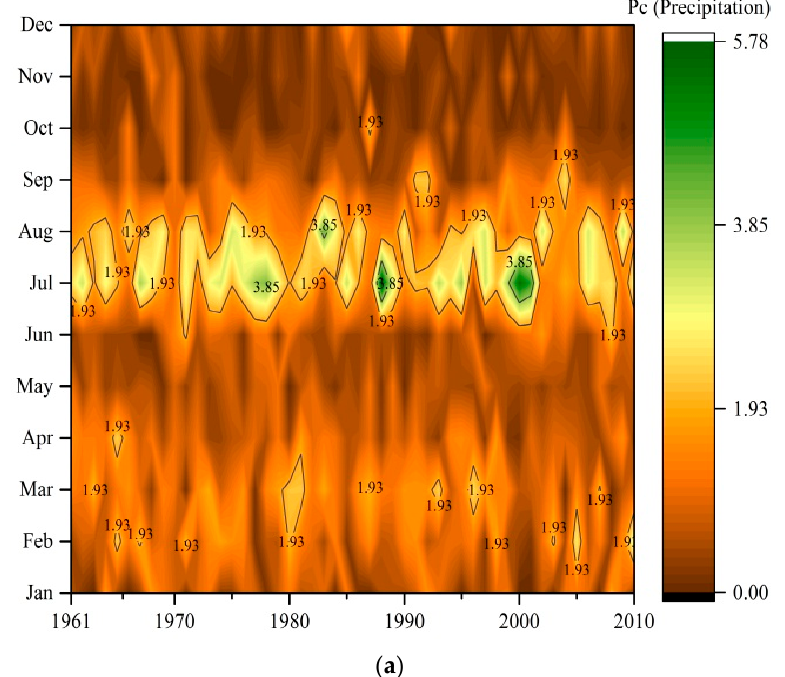
Figure 14. Contours of Parde co-efficient precipitation, runoff and temperature of zone I. ( a ) precipitation ( b ) runoff ( c )